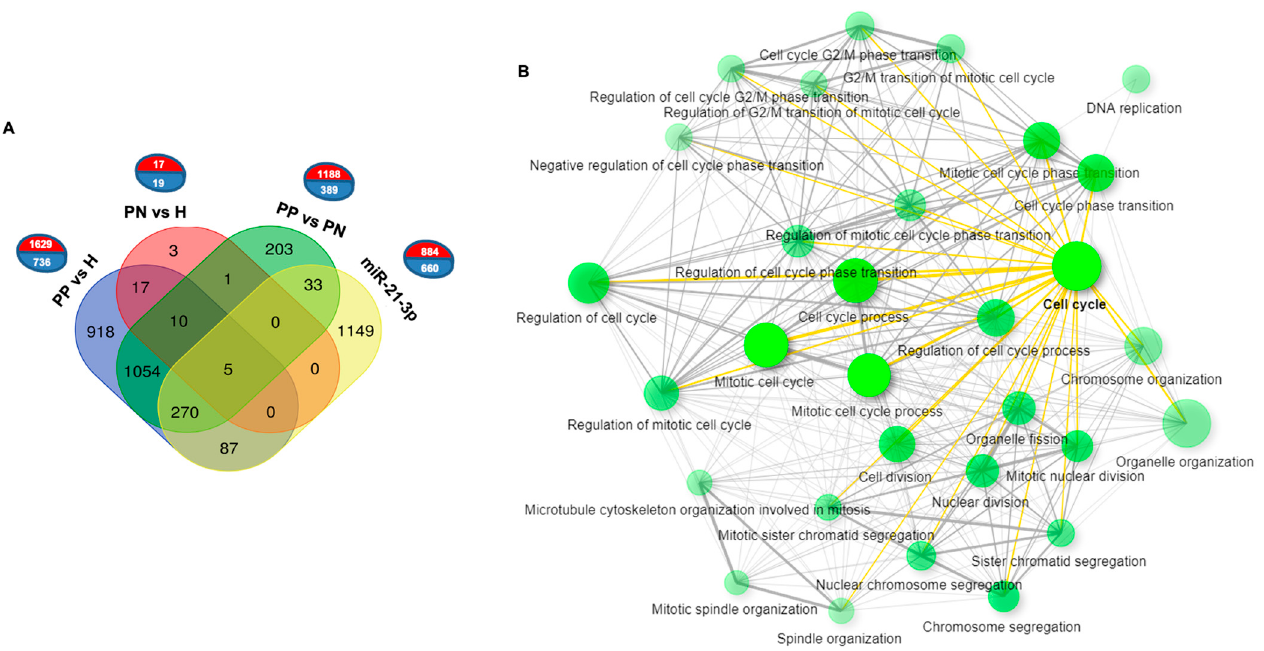
Figure 7. Comparative analysis between miR-21-3p-overexpressing KCs and psoriatic skin. ( A ) Graphs representing the numbers of significant DEGs (red: upregulated; blue: downregulated) between the indicated groups (PP vs. H, PN vs. H and PP vs. PN, from Pasquali et al., 2019 [9] and miR-21-3p, from this work). The Venn diagram shows the extent of overlap among DEGs. ( B ) Enrichment analysis of the 395 genes upregulated in PP keratinocytes and induced by miR ‐ 21 ‐ 3p.